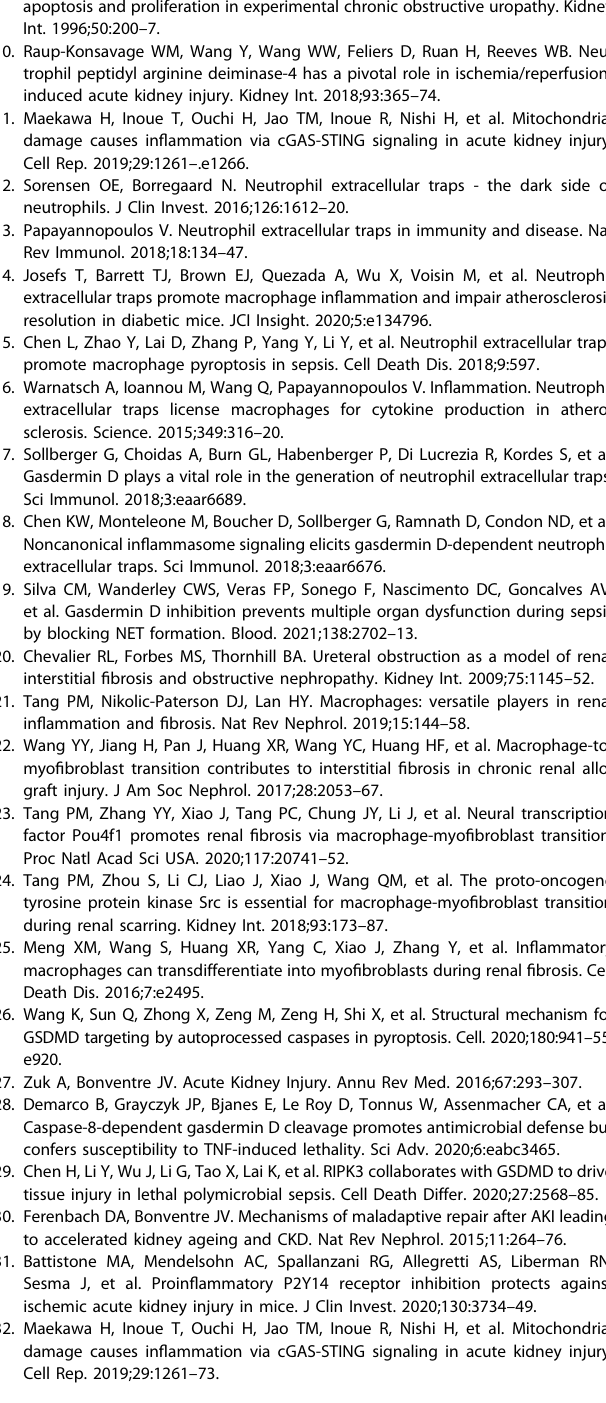
Fig. 8 Speci fi c deletion of Casp11 in neutrophils inhibited NETs formation and renal fi brosis after UUO. A Western blot showing caspase11 activation in the kidneys after UUO. Kidney tissue lysates were isolated on day 0, 2, 5, and 10 after UUO. n = 4. B Representative images of Masson trichrome staining of kidney sections from Casp11 wt/wt Mrp8 cre and Casp11 fl / fl Mrp8 cre mice on day 13 after UUO. Scale bar: 100 μ m. n = 6. C , D Representative images of immuno fl uorescence staining of kidney sections from Casp11 wt/wt Mrp8 cre and Casp11 fl / fl Mrp8 cre mice, showing the expression of α -SMA C and Col I D . DAPI (blue) was used for nuclear staining. Scale bar: 100 μ m. E Representative images of immuno fl uorescence staining of kidney sections from Casp11 wt/wt Mrp8 cre and Casp11 fl / fl Mrp8 cre mice on day 10 after UUO, showing the expression of Histone-H3 and MPO. Scale bar: 100 μ m. F , G Representative images of immuno fl uorescence staining of Cit-H3 and MPO and quanti fi cation of neutrophils undergoing NETs formation. The neutrophils were isolated from Casp11 + / + and Casp11 -/- mice and treated as described in Fig. 7A. n = 6. Scale